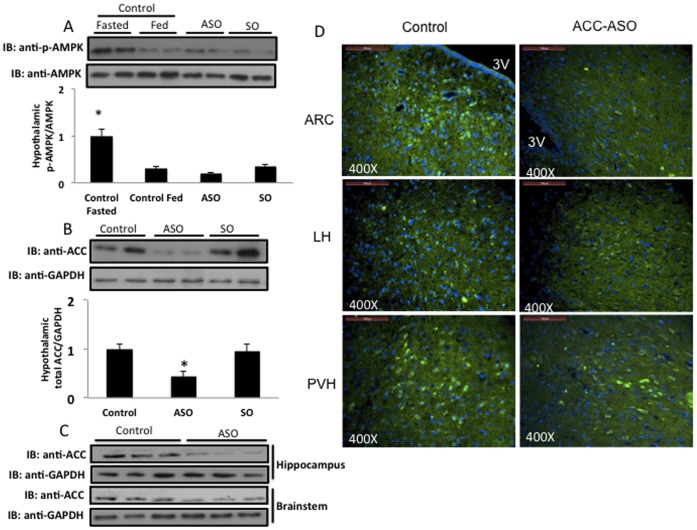
Modulation of AMPK/ACC pathway in central nervous system of ACC-ASO and ACC-SO mice.Representative western blot of hypothalamic p-AMPK (A) and ACC (B) in fasted and fed rats, ACC-ASO (ASO) and ACC-SO (SO). Representative western blot of hippocampus and brainstem area of ACC (C). Representative ACC immunoflorescence staining (green) of samples from hypothalamus (ARC, LH and PVH) of Wistar rats. Cell nuclei were counterstained with DAPI (blue) (D). Bars show quantification of total p-AMPK and ACC proteins normalized by either total GAPDH or AMPK. Data are means ± SEM of five rats. (A)*p≤0.05 vs. control fed, ASO and SO. (B)*p≤0.05 vs. control and SO.